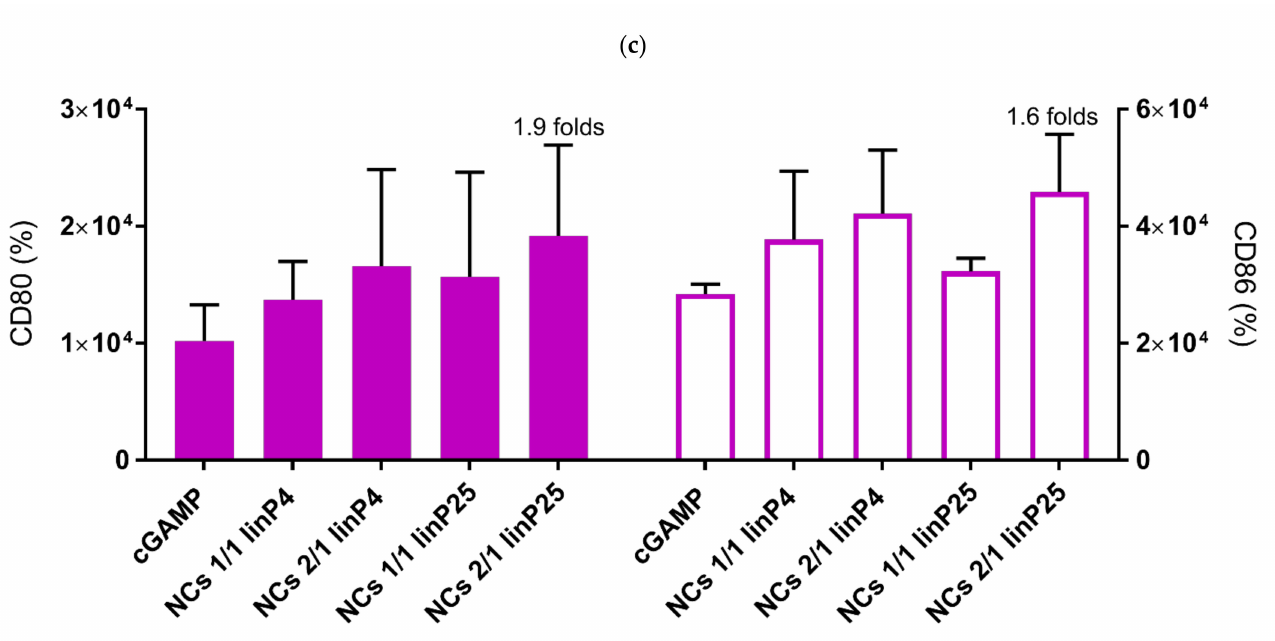
Figure 2. ( a ) WST-1, mitochondrial activity of BMDC after 24 h of exposure to 0.01 mg/mL PEI/cGAMP NCc, ( b ) ELISA, IFN β level of after 2 h of exposure to PEI/cGAMP NCs, fresh media replacement and 24 h collection and ( c ) 24 h NCs exposure to BMDC, CD80/86 marker expression. n = 3; * p <